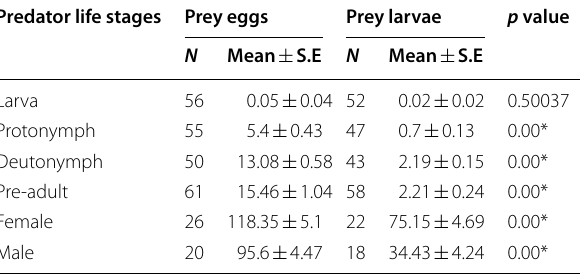
Standard errors were estimated by using 100,000 bootstraps. *Means followed by marked p values are significantly different between two treatments using the paired bootstrap test at the 5% significance level